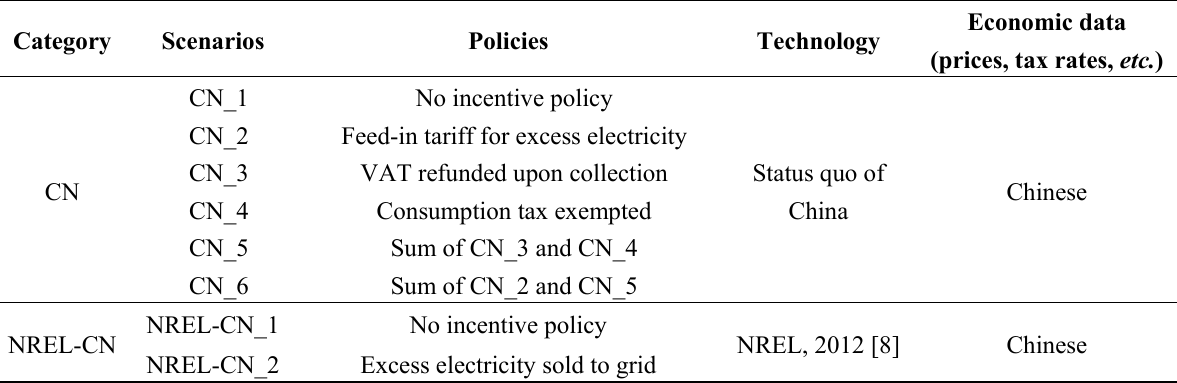
Table 1. Scenarios for techno-economic